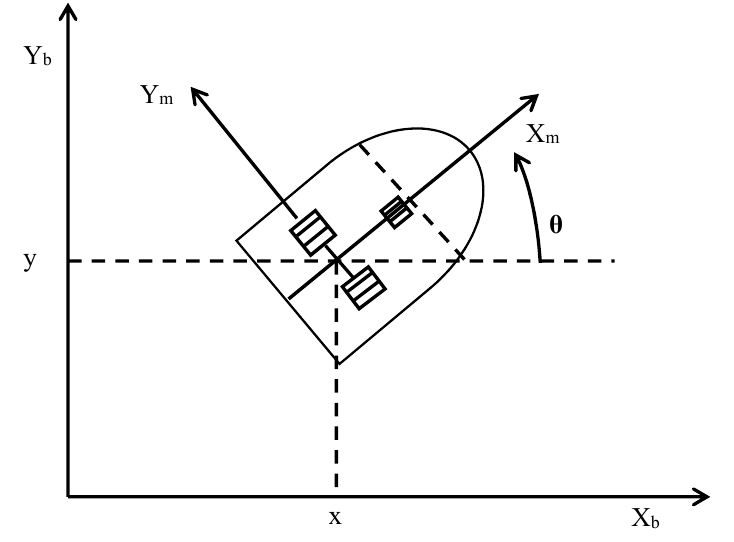
Figure 10. Representation of the mobile robot.